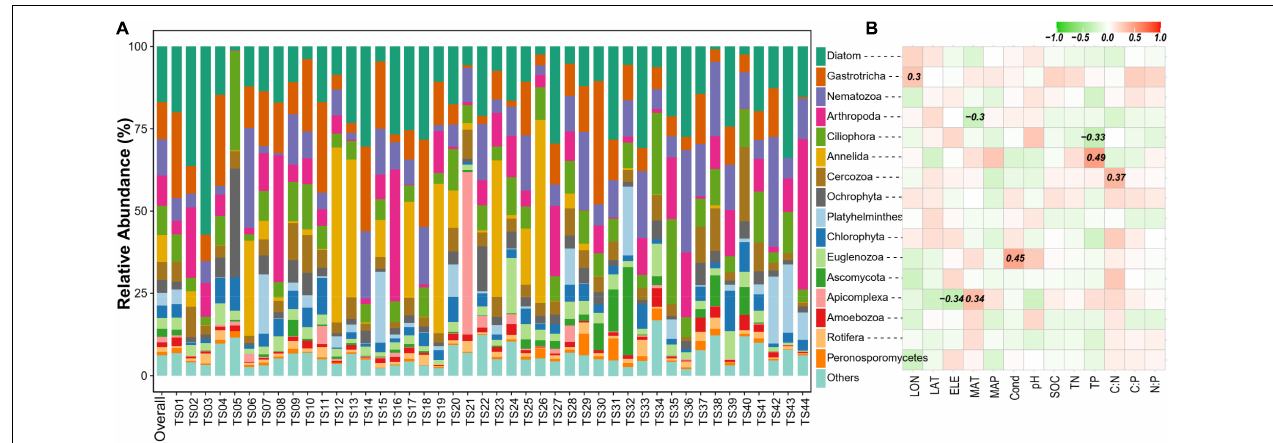
FIGURE 5 | (A) Community composition of sediment microbial eukaryotes at the phylum level. Only phyla with a relative abundance > 1% are shown. “Overall” represents the whole dataset including all samples. (B) Spearman correlations show the relationships between the relative abundance of the major phylum and environmental factors. The color represents the correlation coefficient, which is shown in number when the result is significant ( p < 0.05).